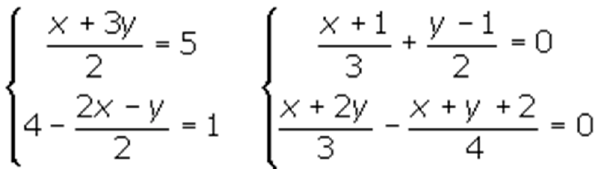
Figure 1. Example of tasks performed.